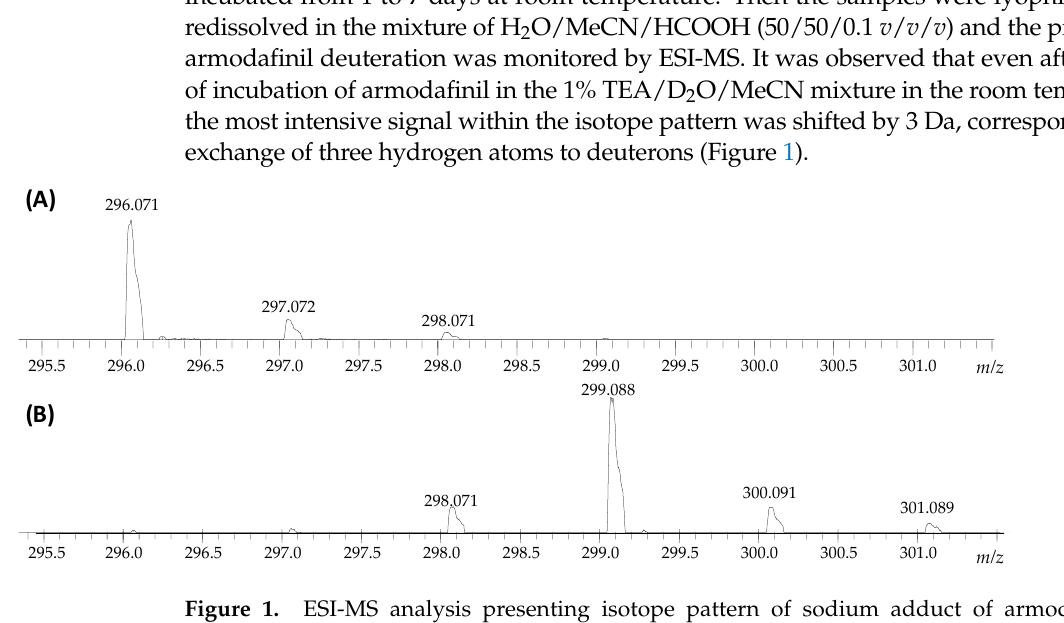
Figure 1. ESI-MS analysis presenting isotope pattern of sodium adduct of armodafinil ion ( A ) before HDX and ( B ) after incubation in the mixture of 1% TEA/D 2 O/MeCN for 3 days in the room temper- ature.